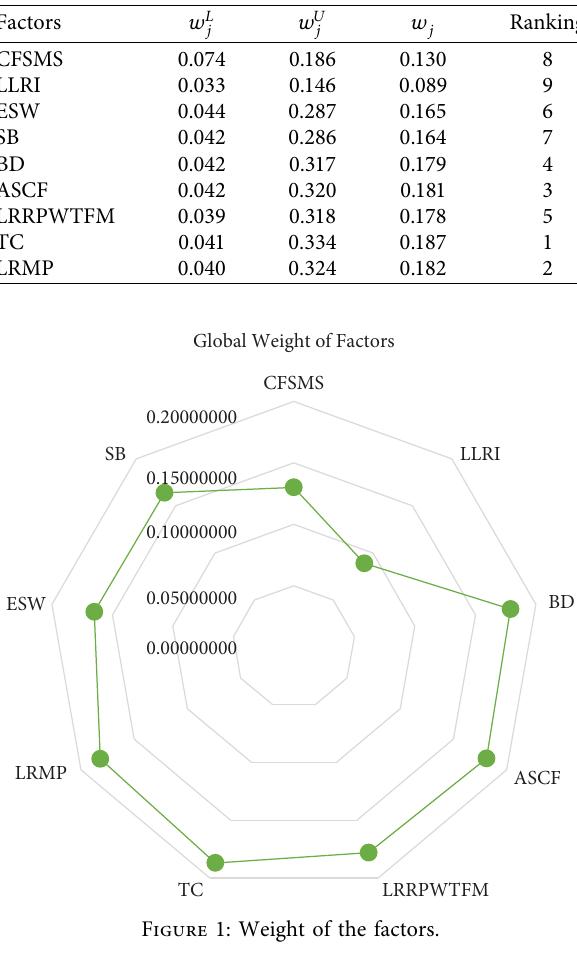
Figure 1: Weight of the